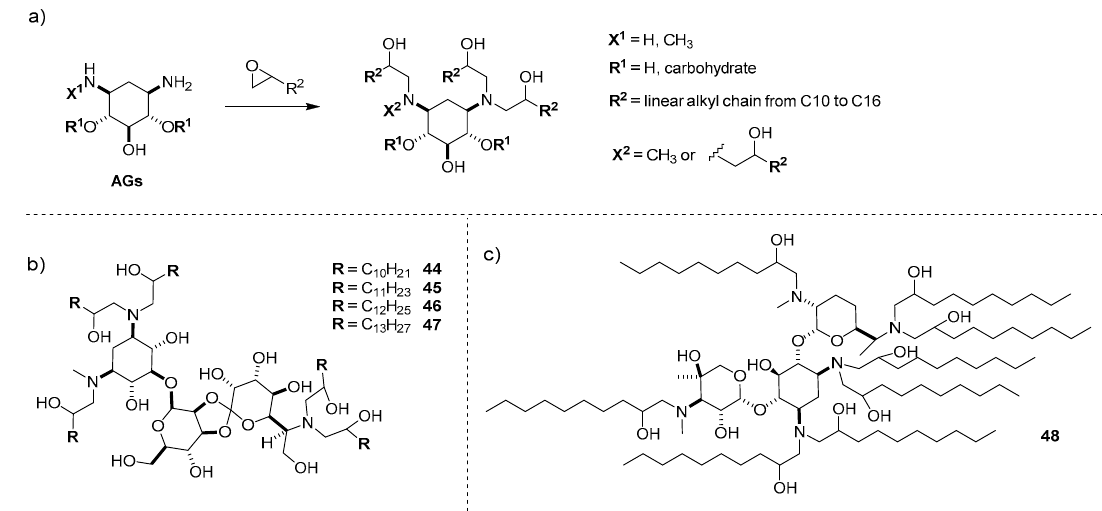
Figure 13. ( a ) Combinatorial synthesis of lipidic modified AGs. ( b ) Structures of the most performant lipids developed at MIT [59] and ( c ) structure of the most performant lipid developed at UT [60].